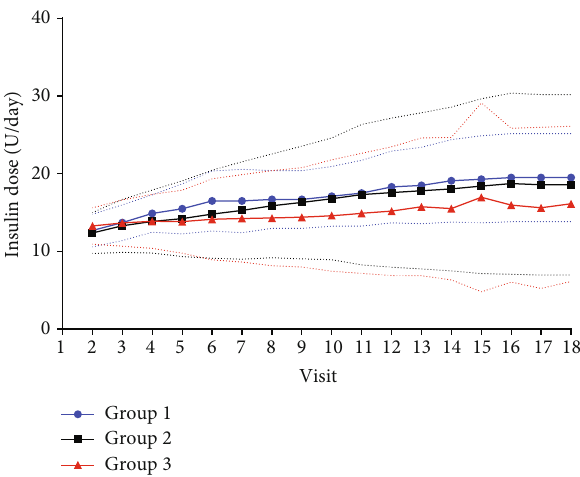
Figure 3: The insulin dose among the three groups during the study